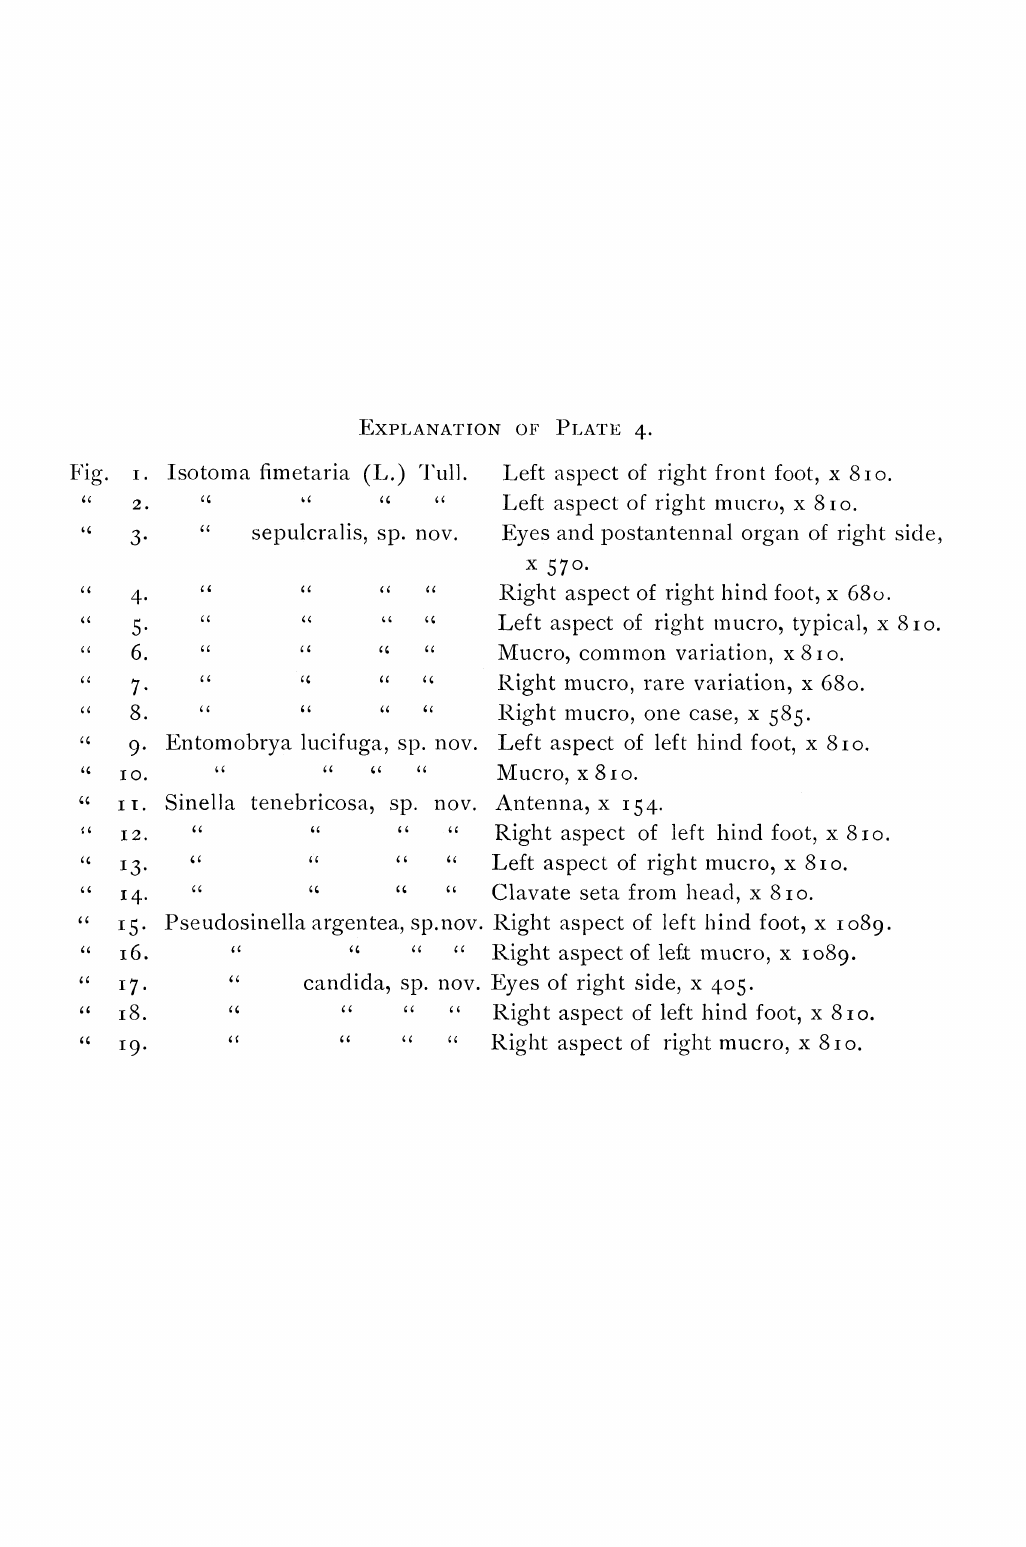
Fig. 1. Isotoma fimetaria (L.) Tull. Left aspect of right front foot, x 81 o. Left aspect of right lnucro, x 81 o. Eyes and postantennal organ of right side, 3. sepulcralis, sp. nov. x 57 o. Right aspect of right hind foot, x 68o. Left aspect of right nucro, typical, x 8 io. Mucro, comtnon variation, x 8 o. Right mucro, rare variation, x 68o. Right mucro, one case, x 585. Mucro, x 81 o. Right aspect of left hind foot, x 8io. " Left aspect of right mucro, x 81 o. Clavate seta from head, x 8 io. Right aspect of lef.t mucro, x io89. Right aspect of left hind foot, x 8io. Right aspect of right mucro, x 81